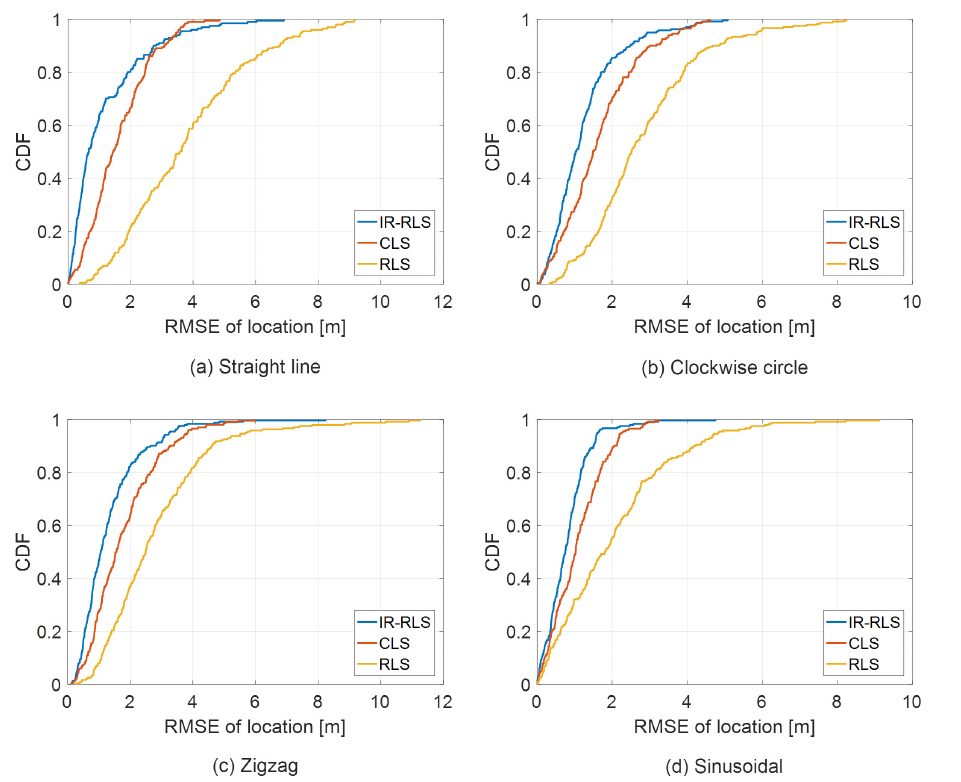
Figure 5. Cumulative distribution function (CDF) comparison of RMSE for different trajectory